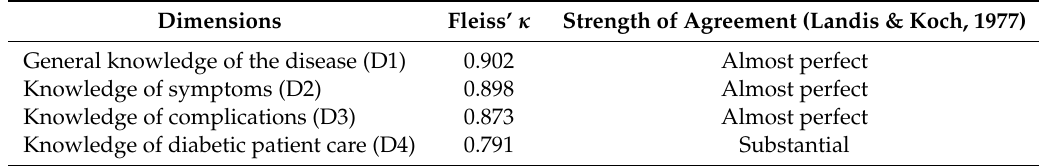
Table 4. Strength of agreement among judges for the dimensions of the original